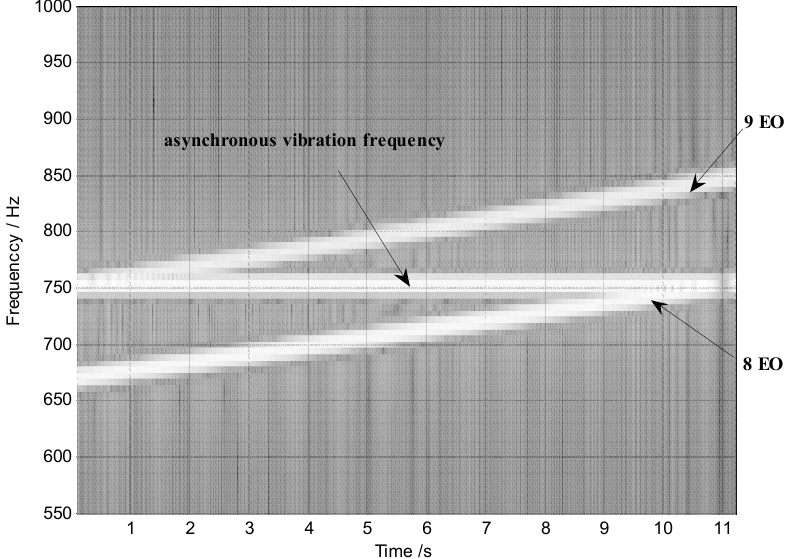
Figure 4. Short-time Fourier transform (STFT) of the original signal.